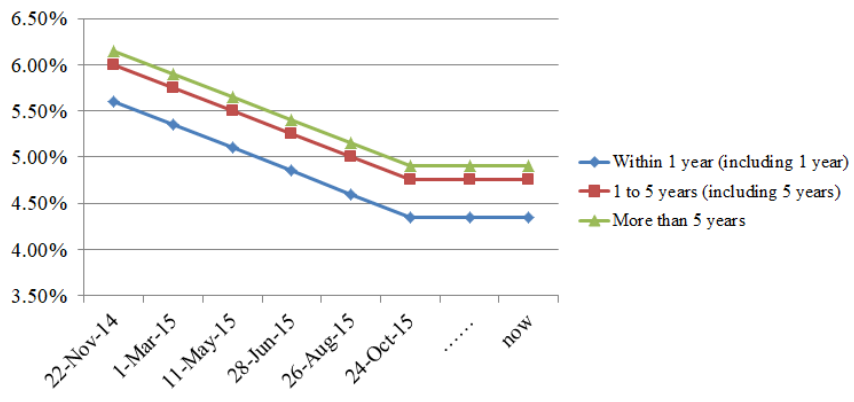
Figure 3. The benchmark lending rate of the People’s Bank of China (2014–2020).